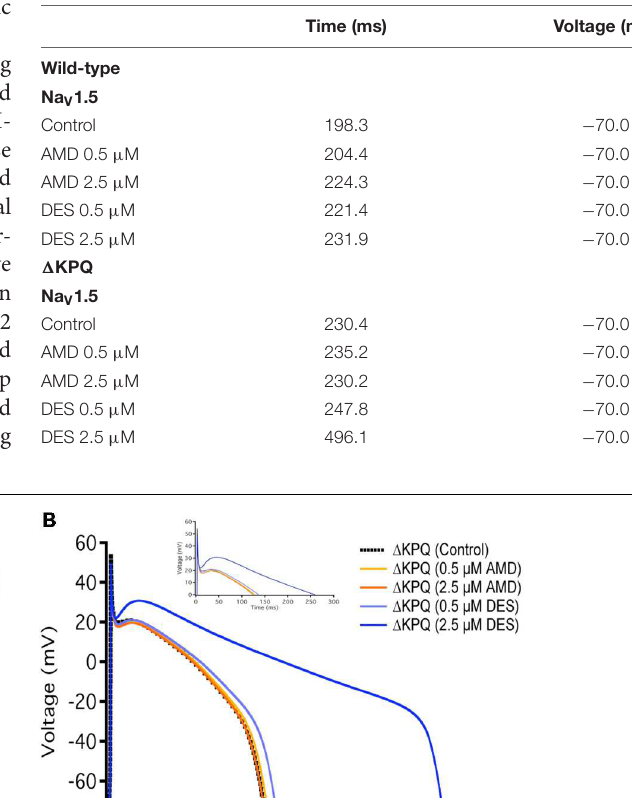
TABLE 6 | Action potential duration.